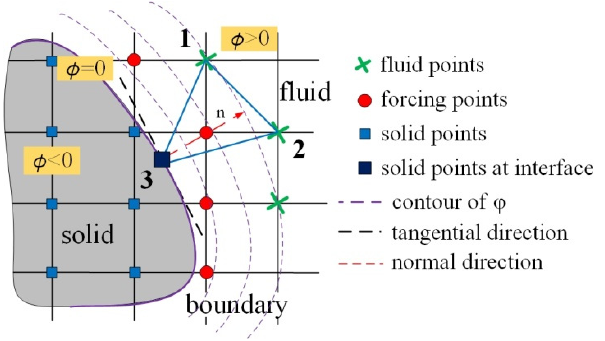
Figure 4. Sketch of the level-set/immersed boundary method.